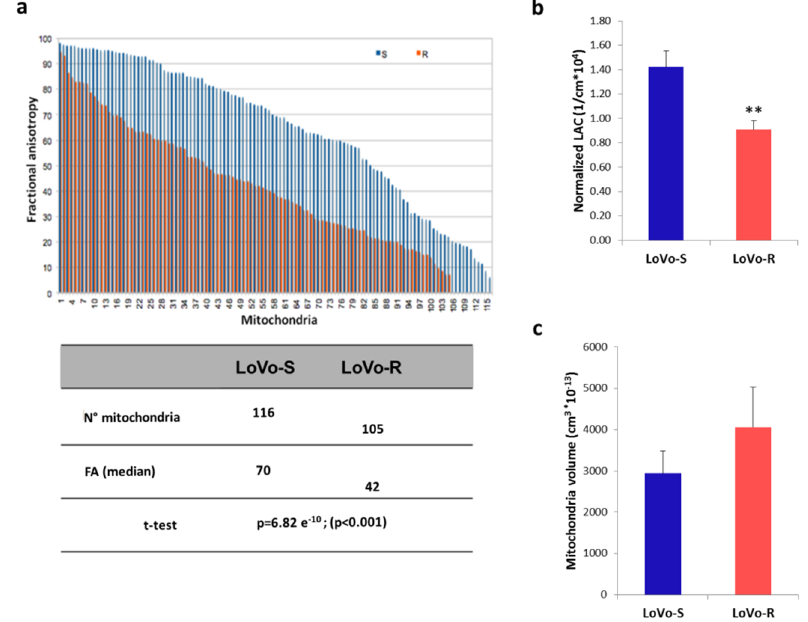
Figure 4. Fractional Anisotropy and LAC of 3D LoVo-S and LoVo-R mitochondria. ( a ) illustrates the average difference in FA between mitochondria of LoVo-S and Lovo-R; in the table, we reported the two median values of FA and the results of comparison using the Student’s t test. In ( b ) Histogram reports the estimated normalized LAC for mitochondria of 7 LoVo-S and 7 LoVo-R. Values are expressed as mean ± standard error of the mean and compared using the Student’s t test (** p < 0.01); in ( c ) histogram reports the measured volume of mitochondria in 7 LoVo-S and 7 LoVo-R. Values are expressed as mean ± SEM and compared using the Student’s t test. No statistically differences are obtained.